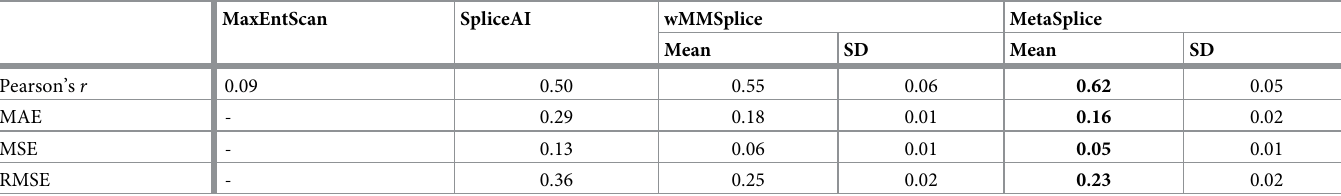
Table 1. Performance of C R predictions by various